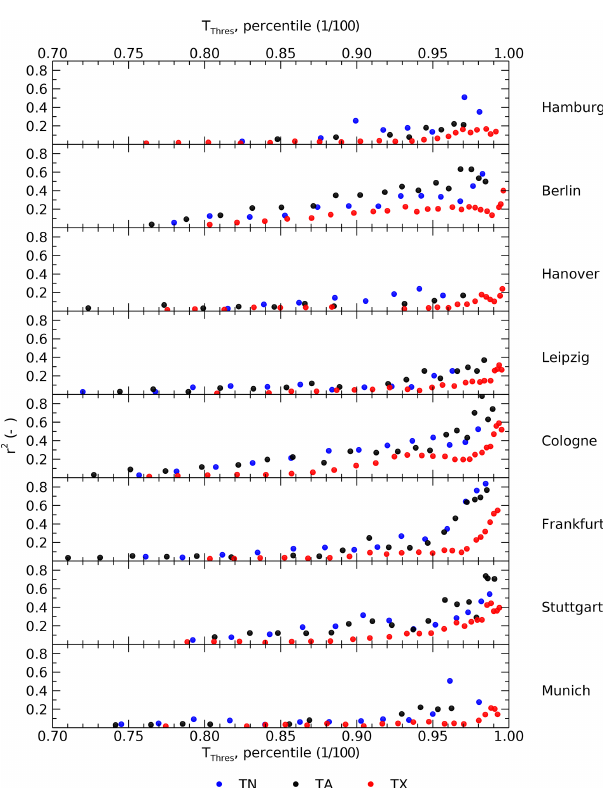
Figure A2. Comparison of regression analysis based on different predictor variables daily minimum air temperature (TN, blue), daily average air temperature (TA, black) and daily maximum air temper- ature (TX, red). Each panel displays results for one city. x axis: percentile of the respective air temperature distribution, y axis: ex- plained variance ( r 2 ) of regression